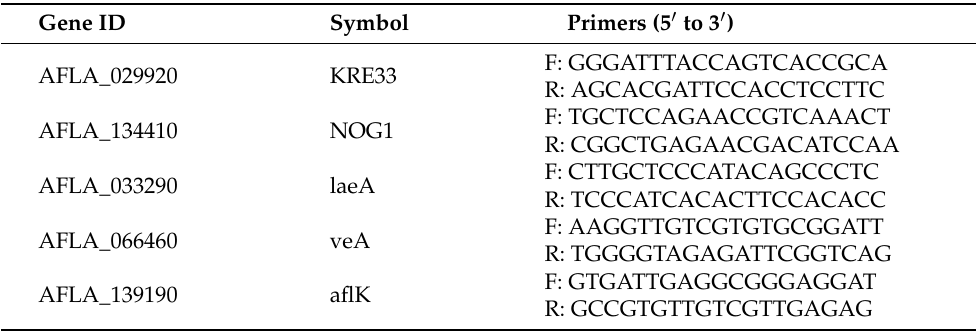
Table 1. Primers used for